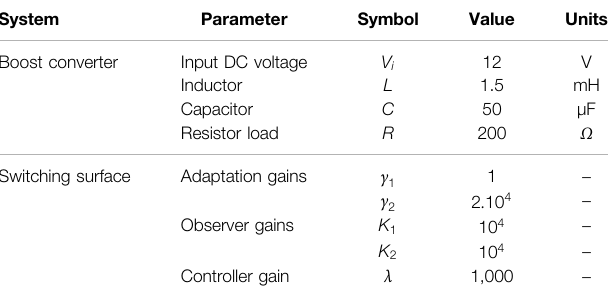
TABLE 1 | The DC-DC boost converter and switching surface parameters.